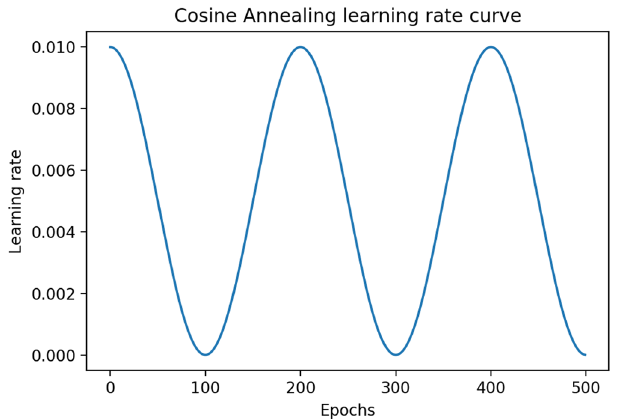
Figure 6. Line plot of the cosine annealing learning rate scheduler used in the training